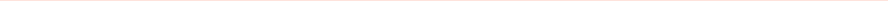
Table 1 . Search strategies in the three databases